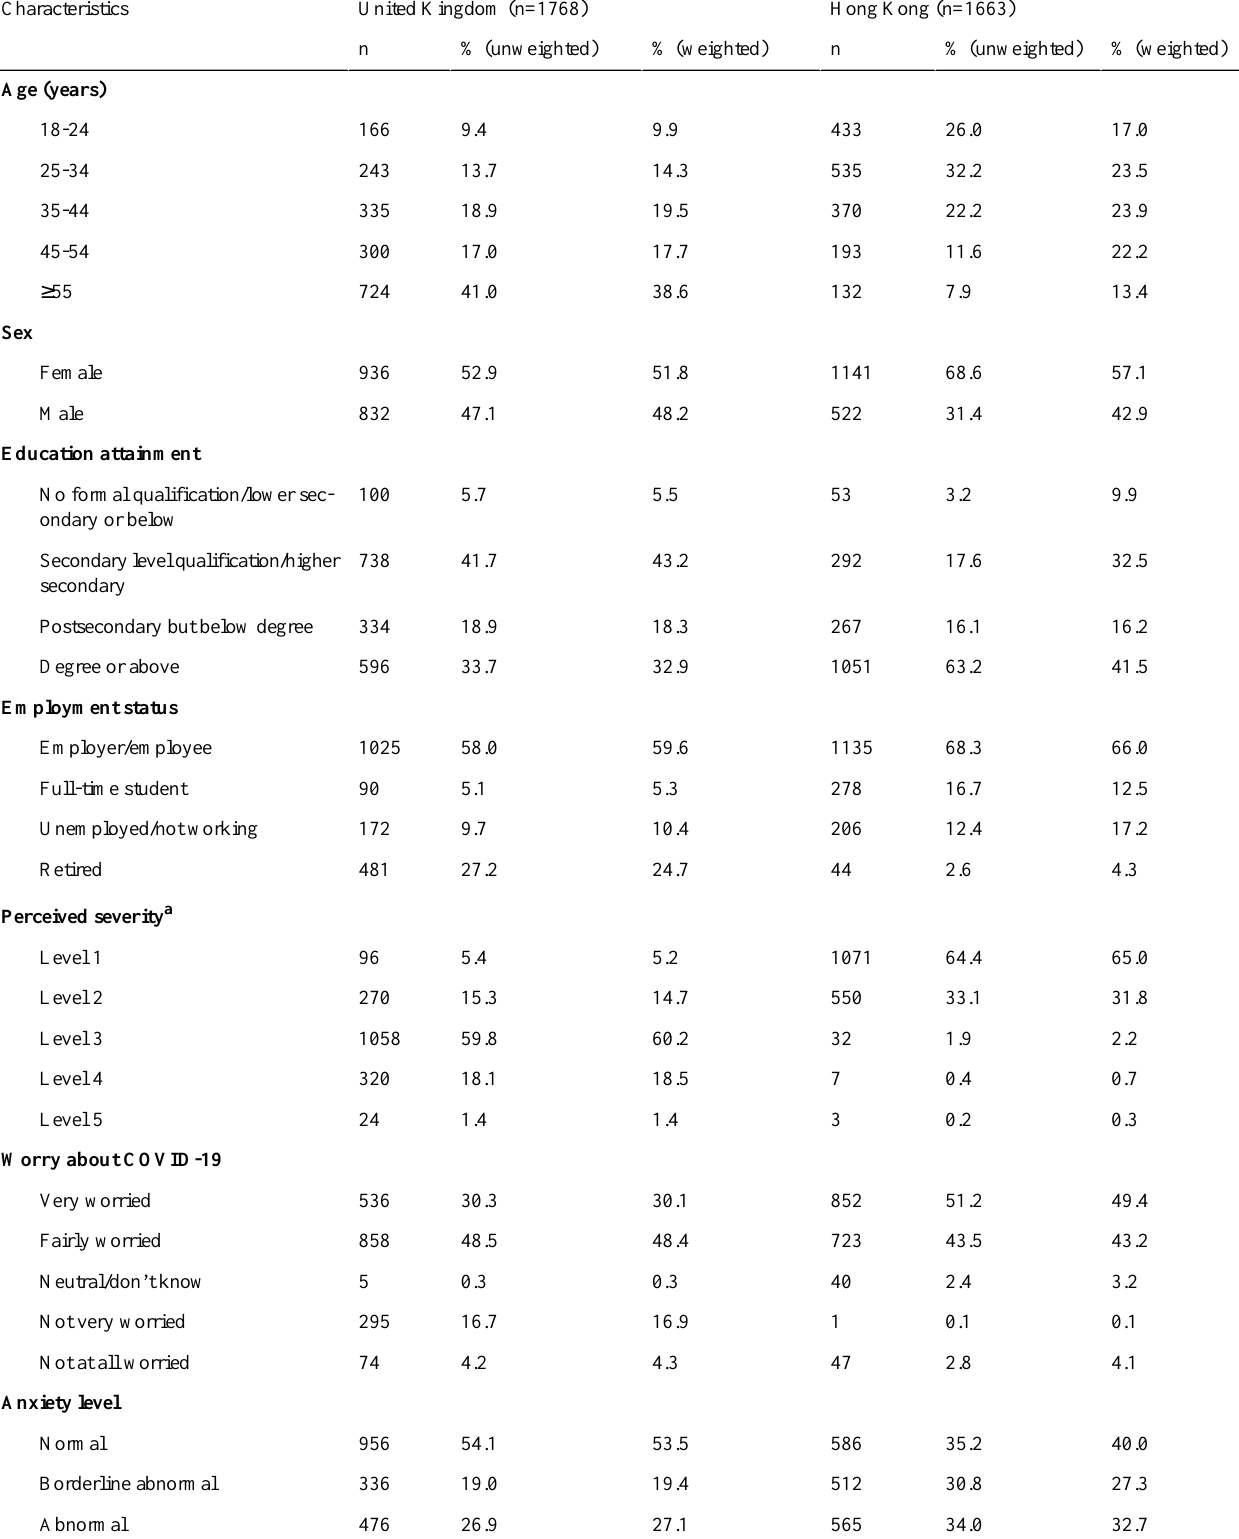
Table 1. Characteristics of the study respondents in the United Kingdom and Hong Kong (all P values <.001 as determined by chi-square goodness-of-fit